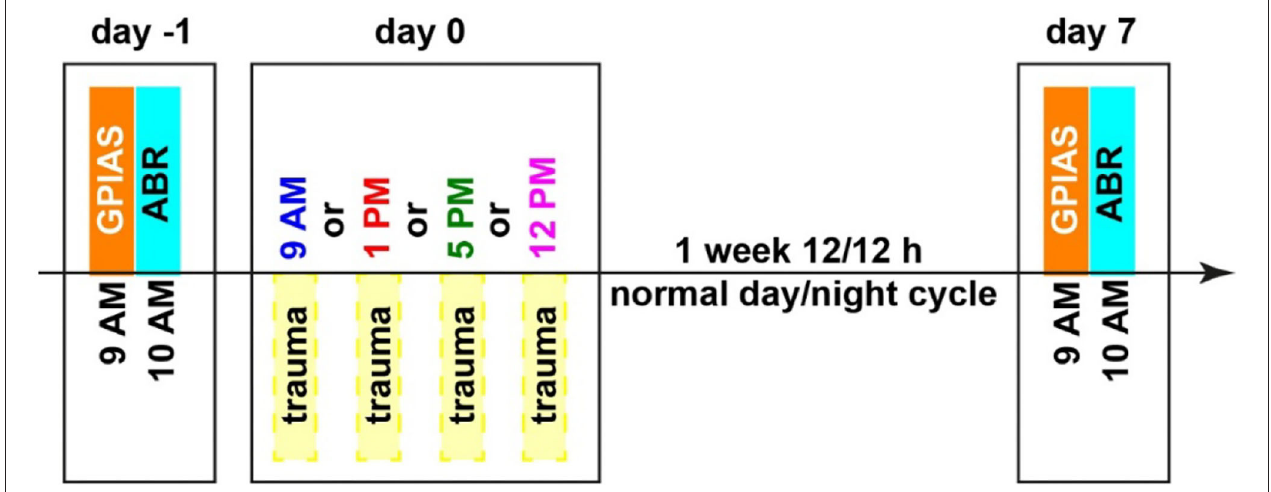
FIGURE 1 | Time regime of behavioral testing for tinnitus assessment (GPIAS), hearing threshold measurements (ABR), and mild acoustic trauma (2kHz, 115 dB SPL, 75min). Different trauma times are depicted in different colors, which will also be used in the following figures. Zeitgeber times (ZT, time of light on) correspond as follows: 9 AM = ZT 3, 10 AM = ZT 4, 1 PM = ZT 7, 5 PM = ZT 11 and 12 PM = ZT